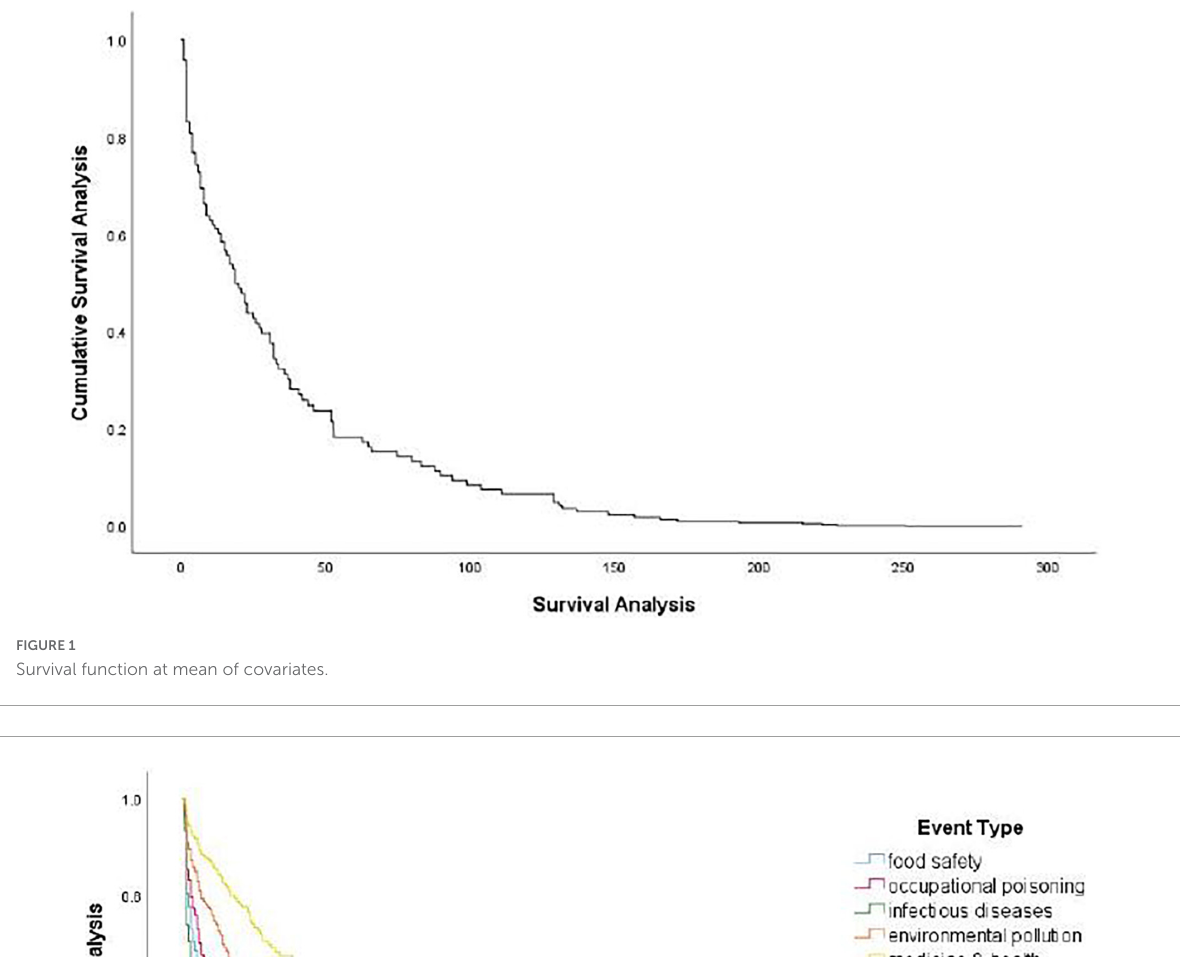
FIGURE1 Survival function at mean of covariates.